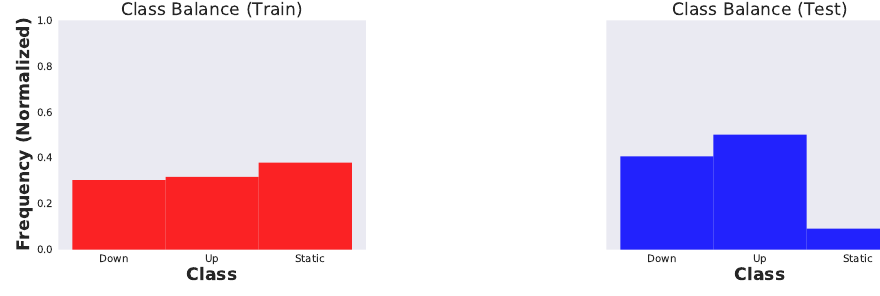
Figure 6. Comparative histogram of training and testing data points (BTCCNY in the OkCoin market). It shows that there was a crucial class imbalance in the testing data, whereas the data points in the training data were relatively balanced. This imbalance is also implied in Figure 3.